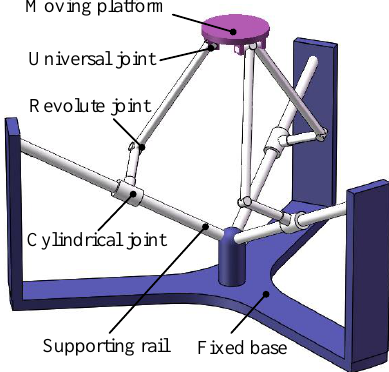
Figure 1. The existing 3-CRU spherical wrist.